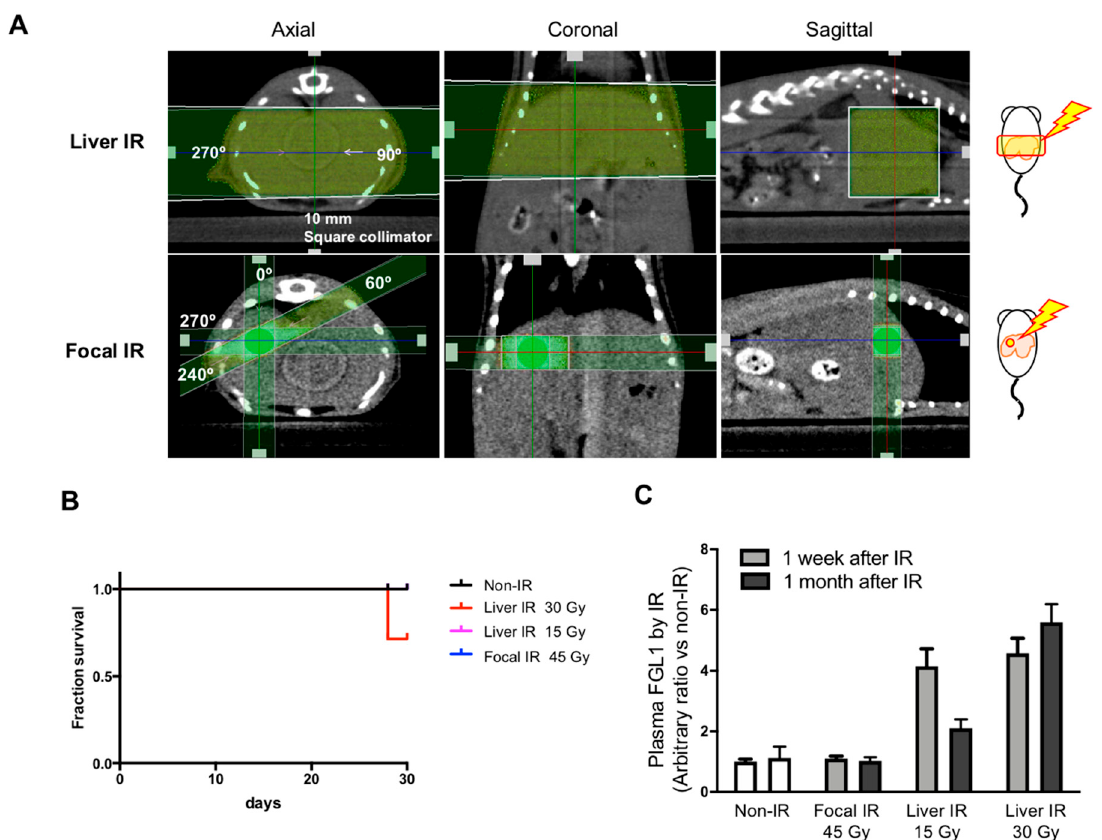
Figure 7. Measurement of FGL1 in mouse plasma following Liver IR or focal IR. ( A ) Schematics and representative photographs of mice exposed to whole liver IR and focal IR to the liver. Liver IR of 15 and 30 Gy was performed to the lateral abdominal region of mice bidirectionally (each 90, 270 degrees with 7.5 Gy and 15 Gy, respectively) using a 10 × 10 mm 2 square collimator. Focal hepatic IR was administered to the right abdominal region of mice in 4 directions with 11.25 Gy (each 11.25 Gy, 0, 60, 240, and 270 degrees) using a 3 × 3 mm 2 square collimator. ( B ) Detection of plasma FGL1 in mice at 7 and 30 days after IR in each experimental group was performed by ELISA (n = 4–7). Data represent the means ± SD. ( C ) 30 day-survival curves of the each group (n = 6–7).